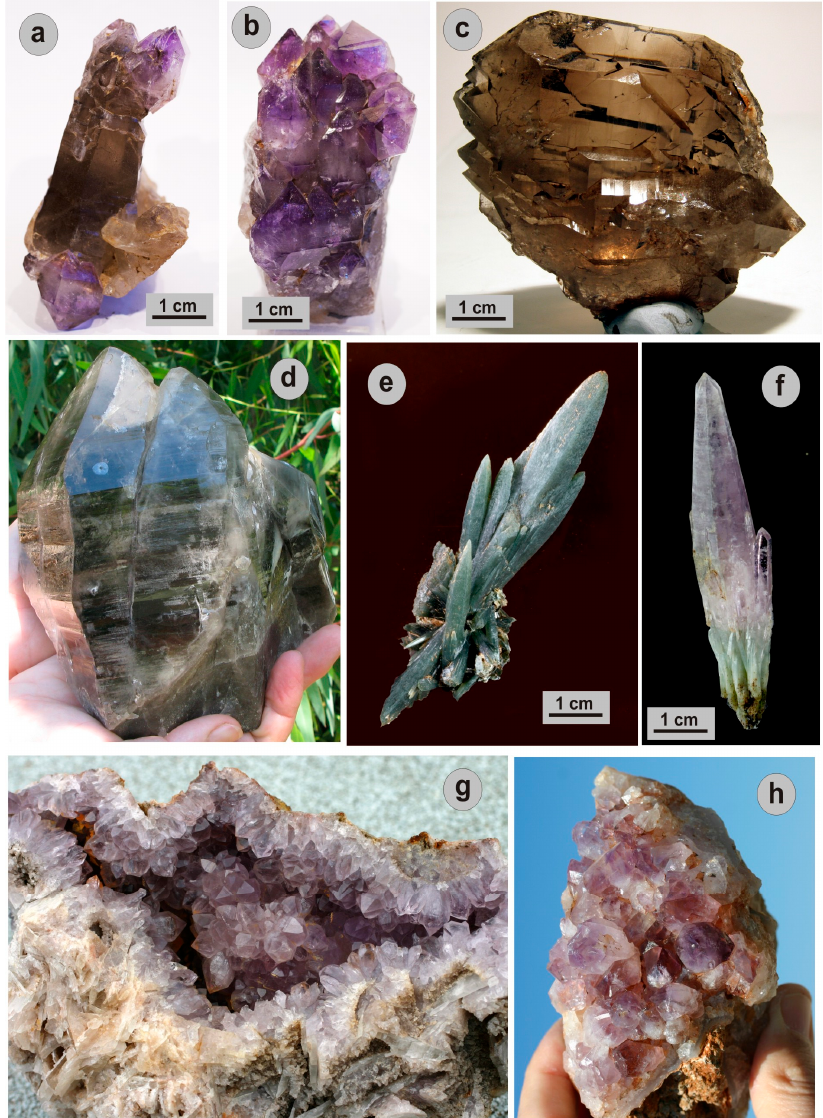
Figure 8. Hand specimens illustrating the gem quartz crystals of Greece: ( a , b ) smoky quartz and amethyst from Dassoto, Drama; ( c ) smoky quartz from Koskina, Evia Island; ( d ) morion from Samothraki Island; ( e ) green quartz from Avessalos, Serifos Island; ( f ) amethyst on green quartz from Avessalos, Serifos Island; ( g ) amethyst on barite from Chondro Vouno, Milos Island; ( h ) amethyst from Kornofolia, Evros district. Photographs 8e,f are courtesy of Berthold Ottens.